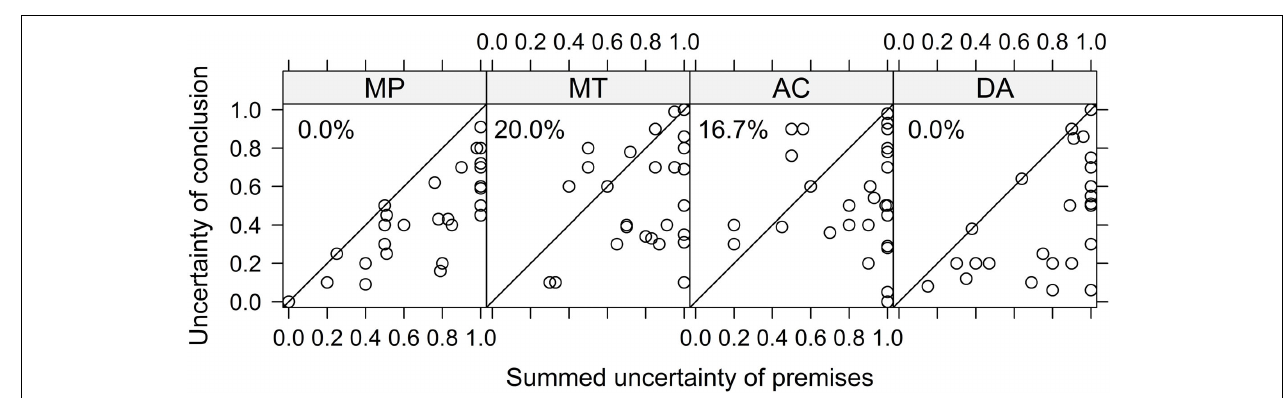
FIGURE 2 | Uncertainty of conclusion (x-axis) vs. summed uncertainties of premises (y-axis) for the four conditional inferences. Each data point shows a single response to one inference. For MP and MT, p -validity is violated if data points fall in the upper triangle (i.e.,